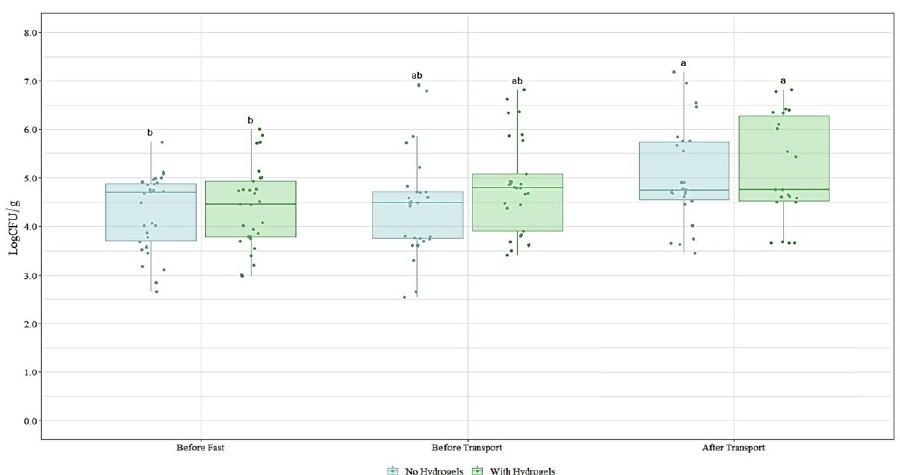
Figure 1. Enterobacteriaceae enumeration from fecal samples. Treatment group ( n = 23) was supple- mented with hydrogel beads during transportation (blue bars) and control groups ( n = 26) did not have access to the beads (green bars). Significant differences ( p < 0.05) are represented with different letters. Samples were collected at each established point: Before Fast ( n =59), Before Transport ( n =60), and After Transport ( n =49).